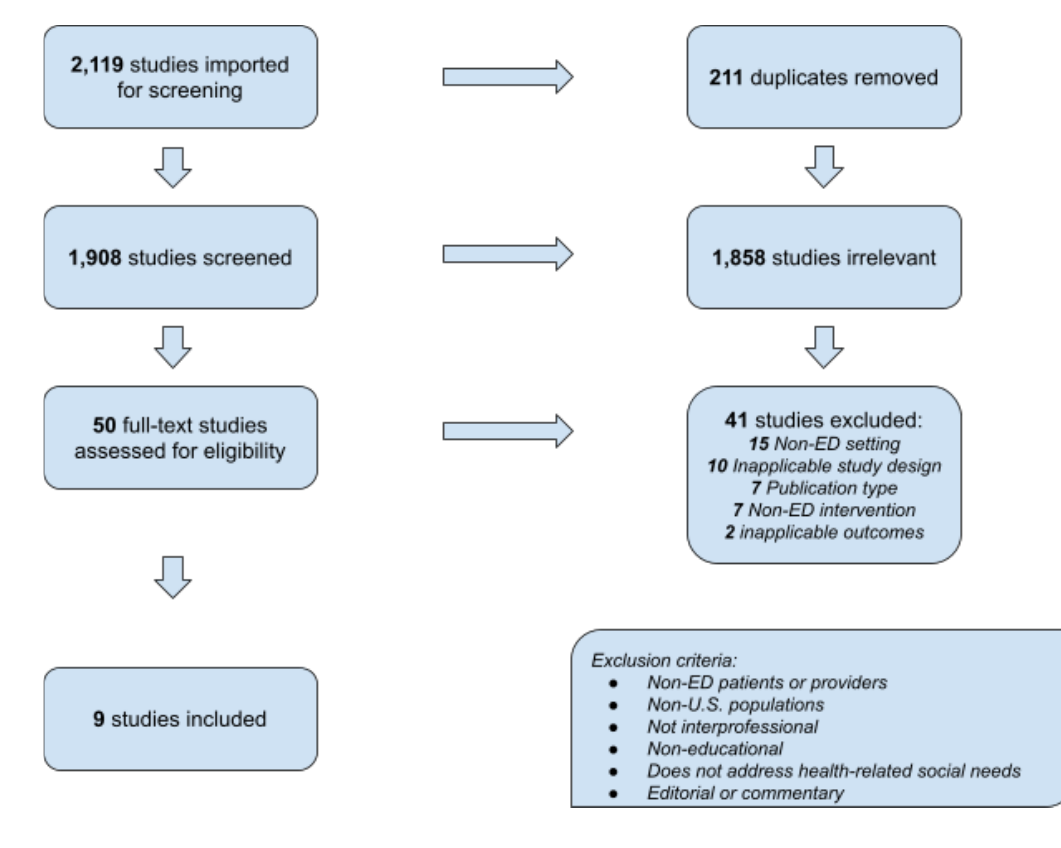
Figure. PRISMA Flow Chart ED , emergency department; Non-U.S , non-United